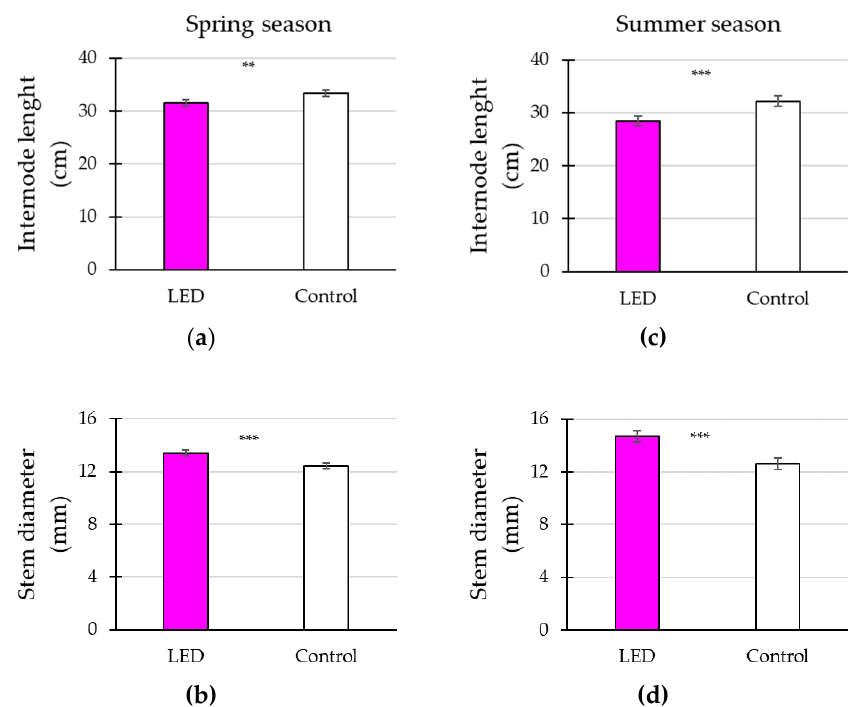
Figure 4. E ff ect of lighting regime on internode length ( a , c ) and stem diameter ( b , d ) during spring ( a , b ) and summer ( c , d ) season. Symbols (**) indicate significant di ff erences at p ≤ 0.01, or p ≤ 0.001 Figure 4. Effect of lighting regime on internode length ( a and c ) and stem diameter ( b and d ) during spring ( a and b ) and summer ( c and d ) season. Symbols (**) indicate significant differences at p ≤ 0.01, or p ≤ 0.001 (***).